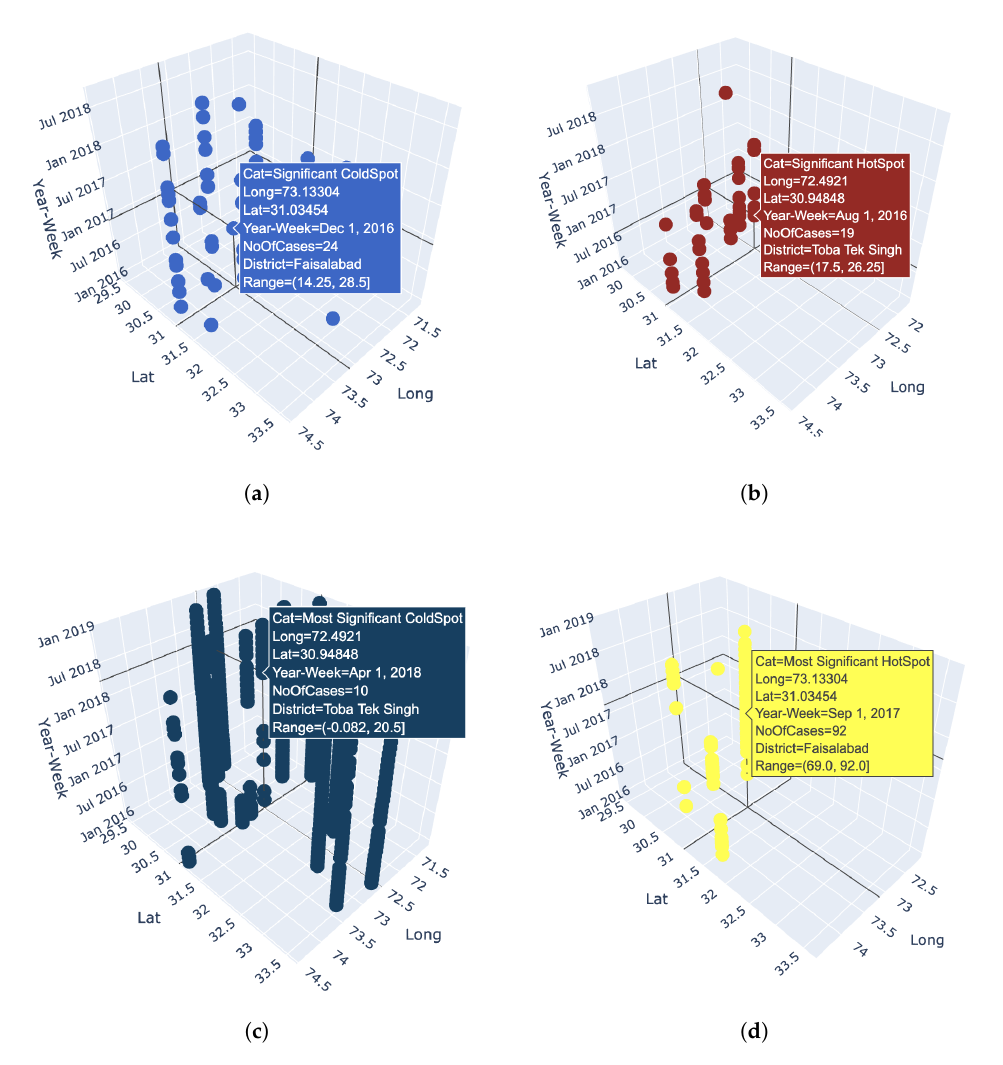
Figure 5. Weekly pattern for four categories of hot and coldspots in at all cluster locations. ( a ) Significant coldspot. ( b ) Significant hotspot. ( c ) Most significant coldspot. ( d ) Most significant